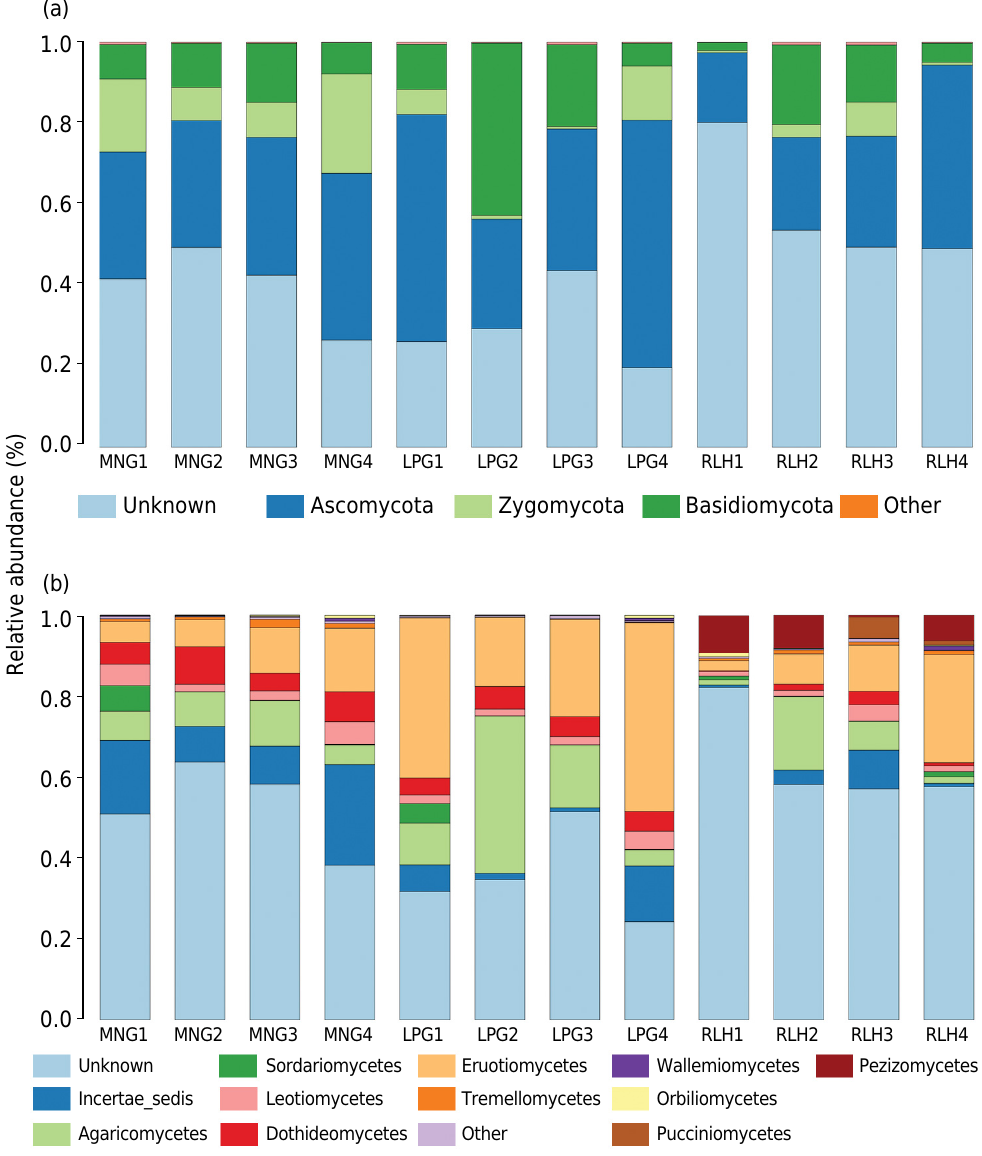
Figure 2. Relative abundance at the microbial taxonomic levels of different treatments. Note: a: fungus phylum; b: fungus class. RLH: raising laying hens under forest; LPG: cultivating Lolium perenne grass under forest; MNG: maintenance of native grass under forest. The number after the treatment symbol means: 1 = spring; 2 = summer; 3 = autumn; 4 =